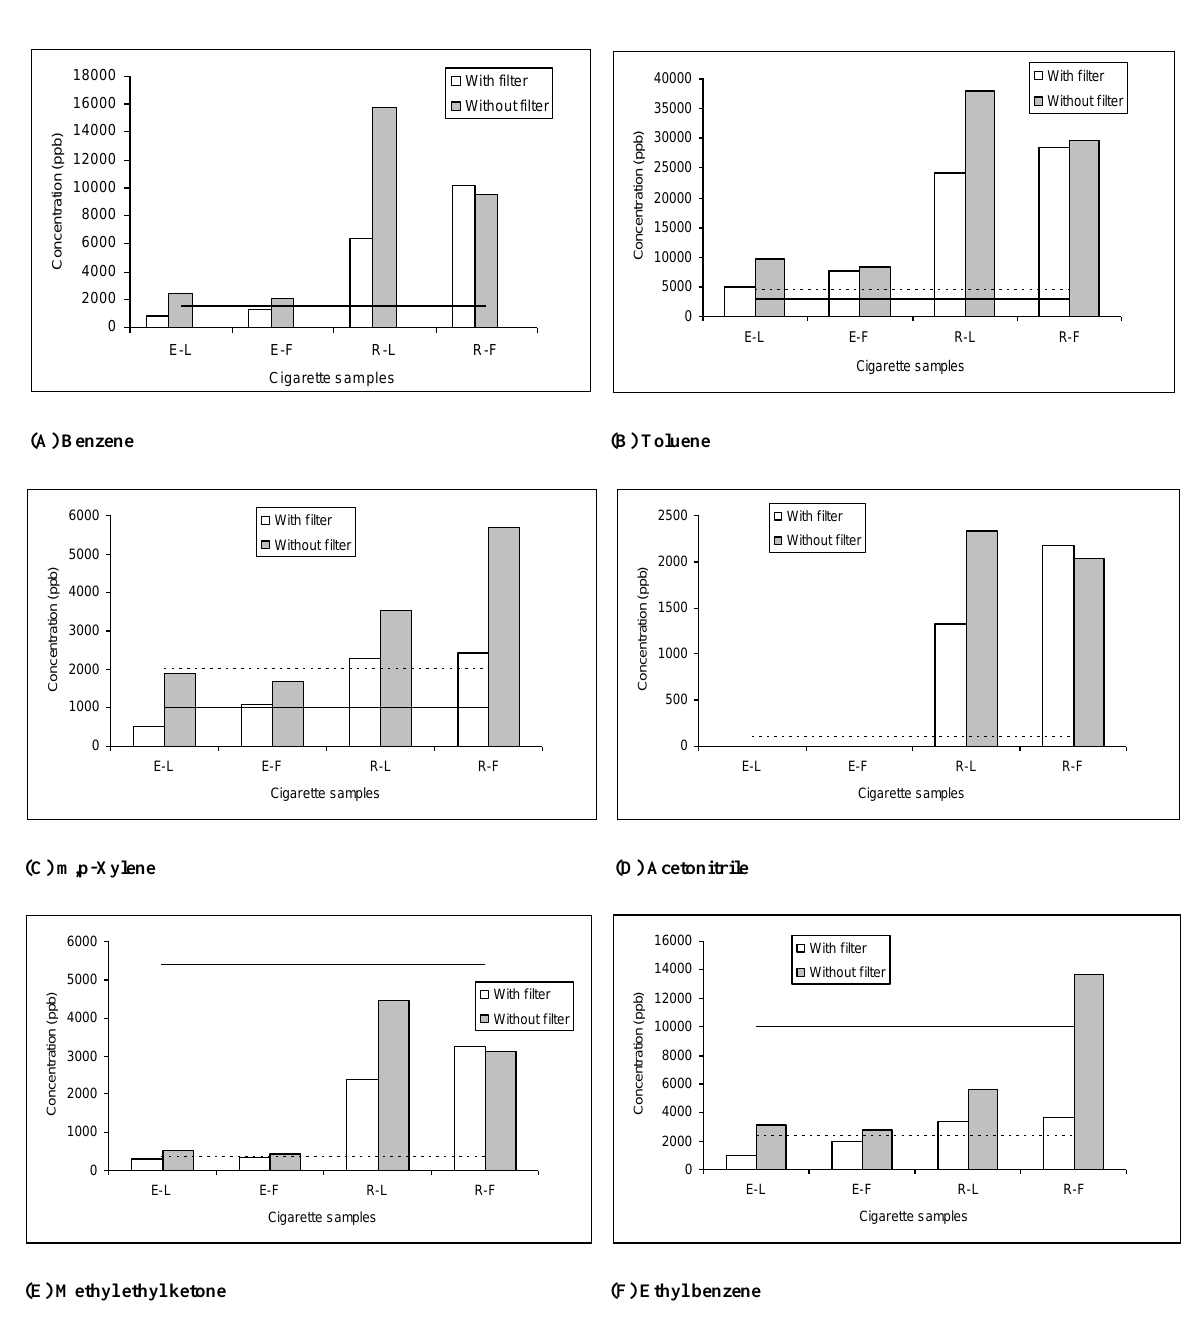
FIGURE 2. Comparison of concentrations of HAPs (listed by the U.S. EPA) from samples collected with filter vs. samples collected after removing the filter. (The comparison with REL and odor threshold values is shown with dotted and straight lines, respectively, as described in Fig. 1). Continued next